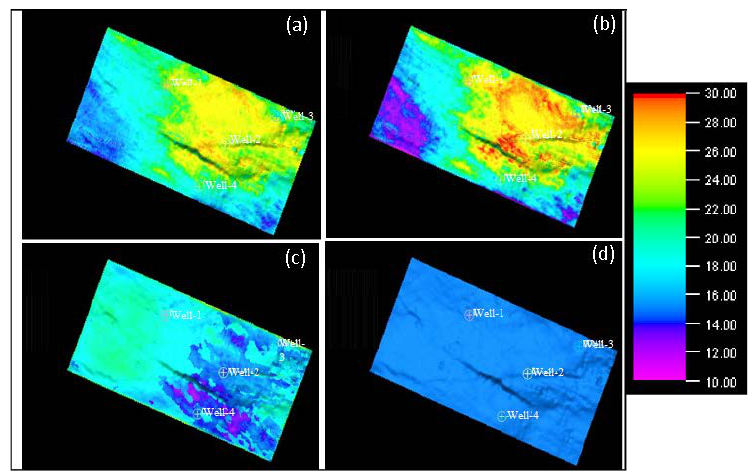
Figure 15. Third mud density cube with 90° inclination and 135° azimuth in lbm/gal for horizontal well in maximum stress direction: ( a ) fracture gradient, ( b ) breakdown, ( c ) breakout, ( d ) kick.